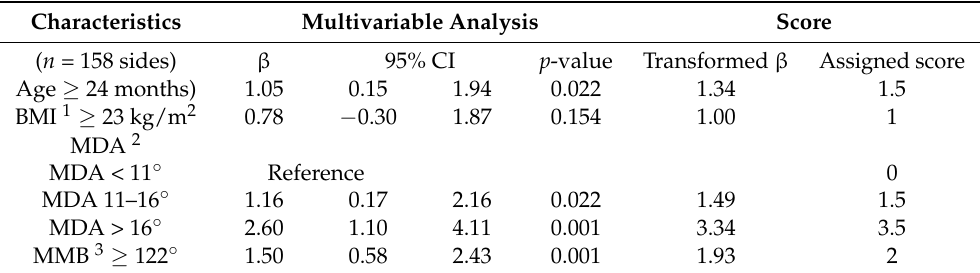
Figure 2. Calibration plot of the observed risk (red circle) and predicted risk (navy line) of Blount’s disease relative to total score from the proposed diagnostic model. Table 4. Multivariable logistic regression analysis for an independent diagnostic predictor of Blount’s disease after backward elimination of preselected predictors with transformed coefficients and assigned scores (imputed dataset n =